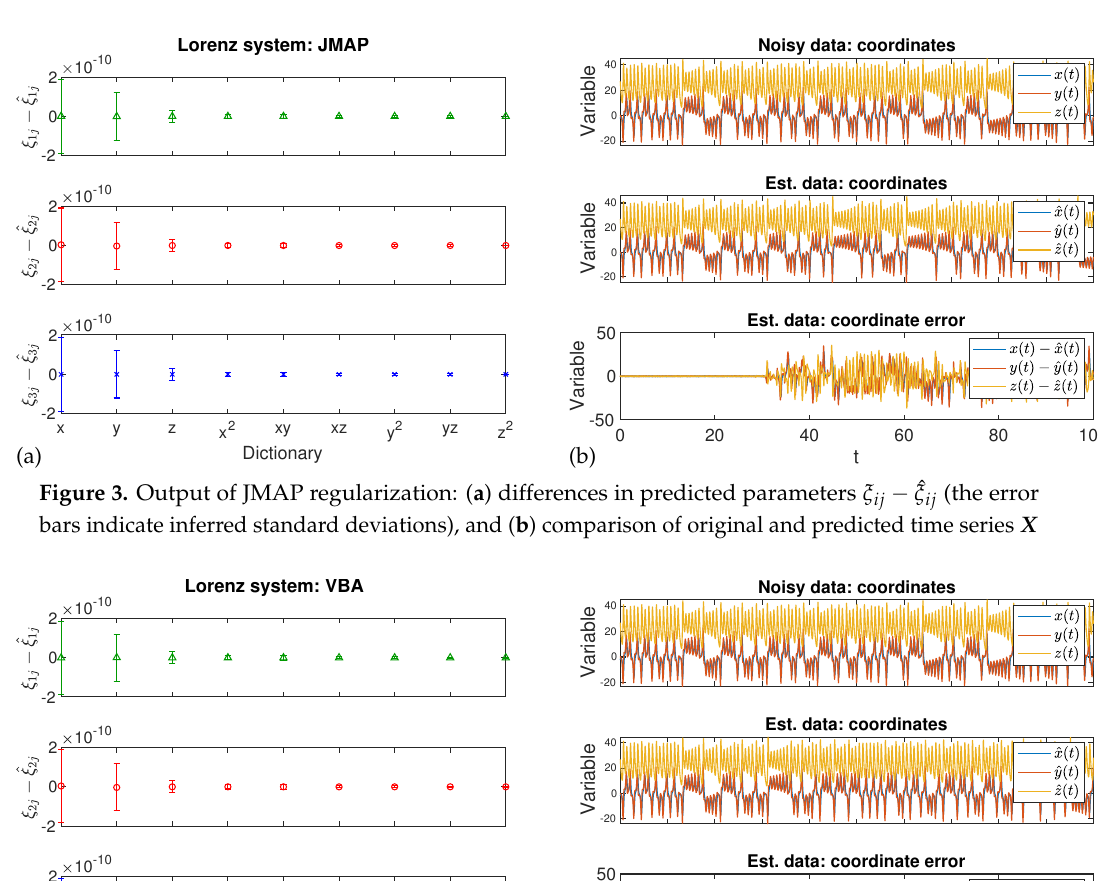
Figure 2. Output of SINDy regularization: ( a ) differences in predicted parameters ξ ij − ˆ ξ ij , and ( b ) comparison of original and predicted time series X .